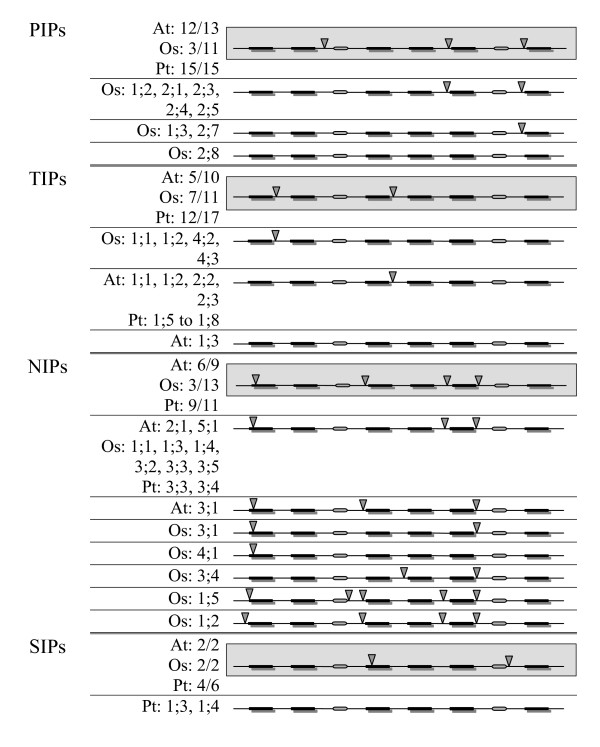
Gene structure of non-XIP MIPs from Populus, Arabidopsis and rice. Exon-intron organization of non-XIP MIP genes from Populus, Arabidopsis and rice is depicted for the PIP, TIP, NIP and SIP subfamilies. The exon-intron pattern observed in majority of MIPs within a subfamily is shown in gray background. In this case, only the number of MIPs having that pattern is indicated for each plant species. For example, "At:12/13" indicates that 12 out of 13 AtPIPs have the same gene structure. For those members with different exon-intron organization, the MIP name is explicitly given (example: Os:2.8 in PIP subfamily). The six TM regions are shown in black bars and the loops B and E are shown in oval shape. The intron positions are indicated by inverted triangle.